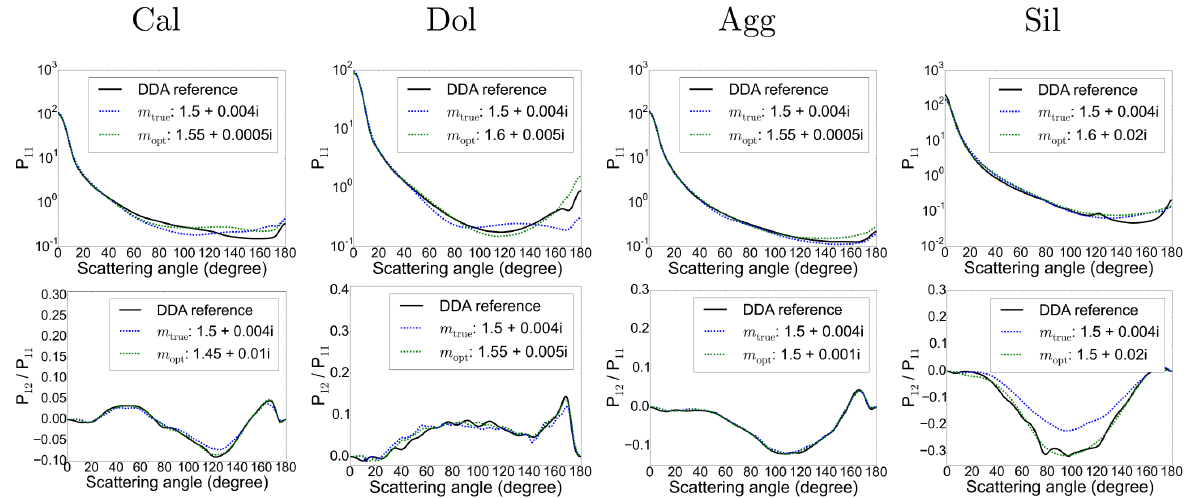
Figure 7. Target scattering matrix elements for P 11 and P 12 /P 11 for the four individual particles as well as the best fits produced by the true refractive index ( m true ) and the optimum refractive index ( m opt ) ellipsoid bases.